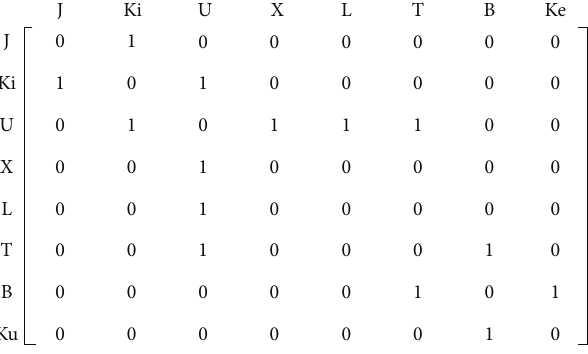
Figure 3: Adjacency